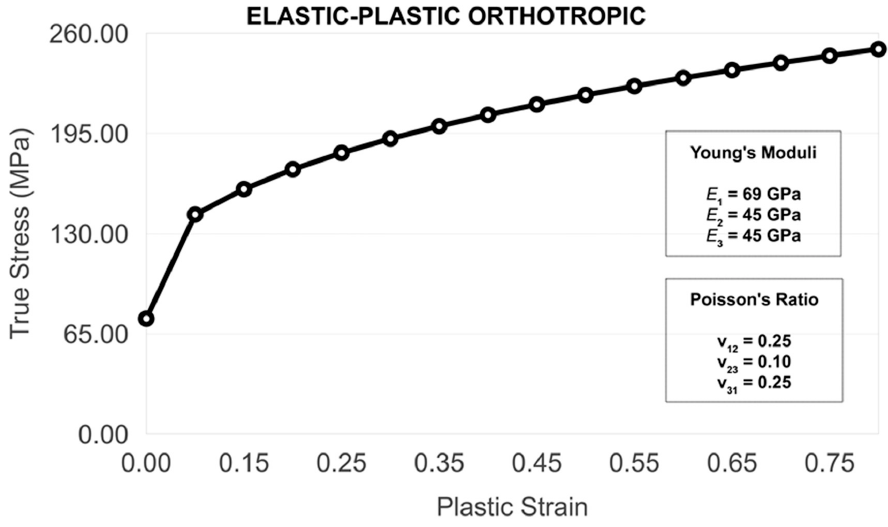
Figure 2. The stress – strain curve of the aluminum alloy 6063 having a 66- μ m grain size.